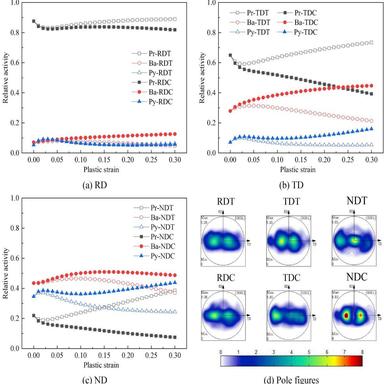
Relative activities of individual deformation modes under different loading conditions when only Pr, Ba and Py are activated in the thought experiment, and the predicted pole figures after 20% tension/compression along six directions. The deformation along the RD is dominated by Pr, and by Pr and Ba along the TD, and by Ba and Py along the ND. The pole figures do not change dramatically in slip dominated deformation.